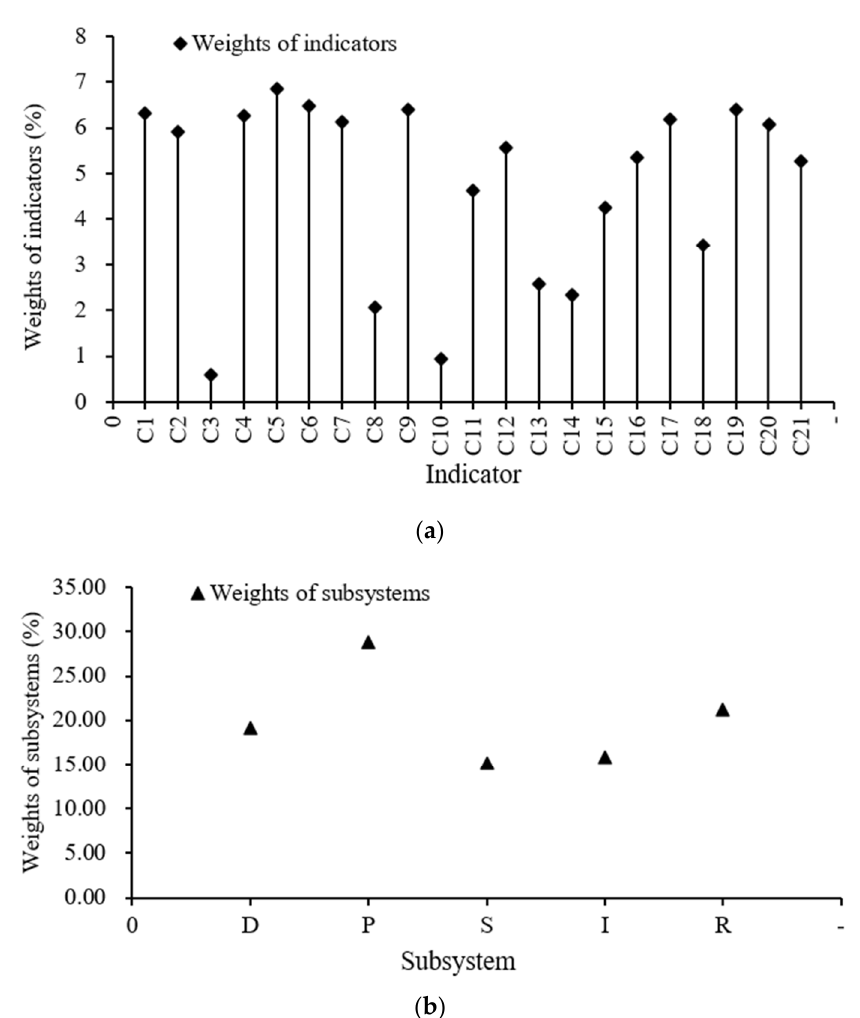
Figure 3. Weights of the indicators ( a ) and subsystems ( b ) in the WRCC indicator system.